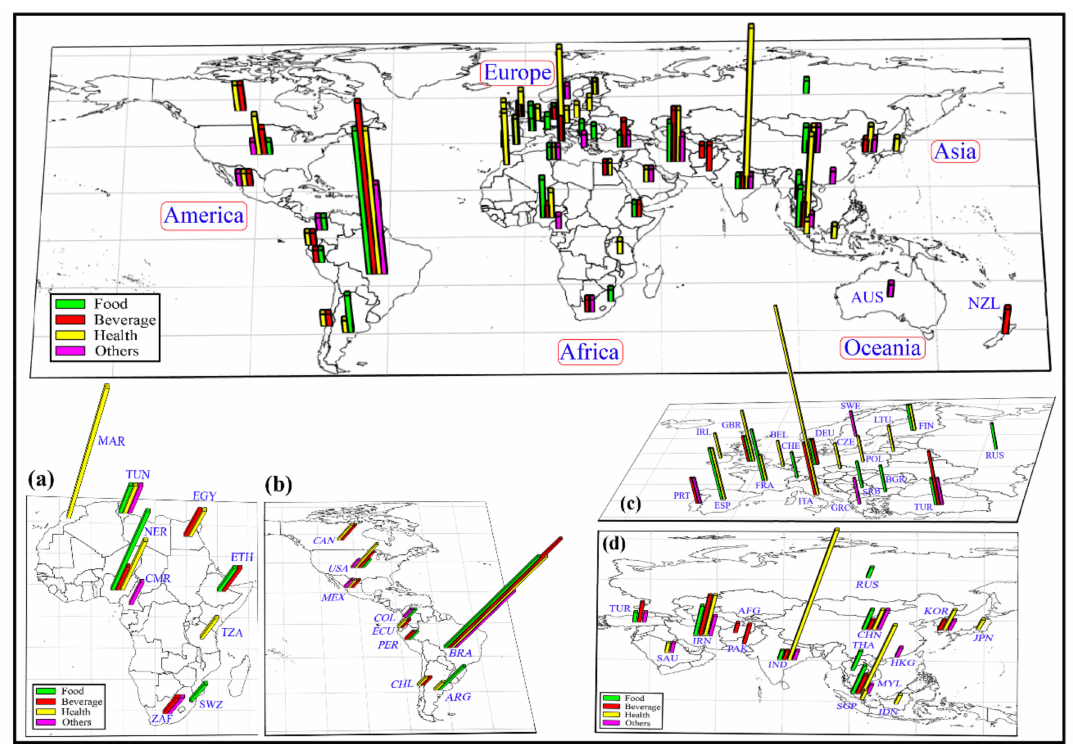
Figure 2. Application of mixture designs around the world between 2016 and 2020. Africa ( a ), America ( b ), Europe ( c ), and Asia ( d